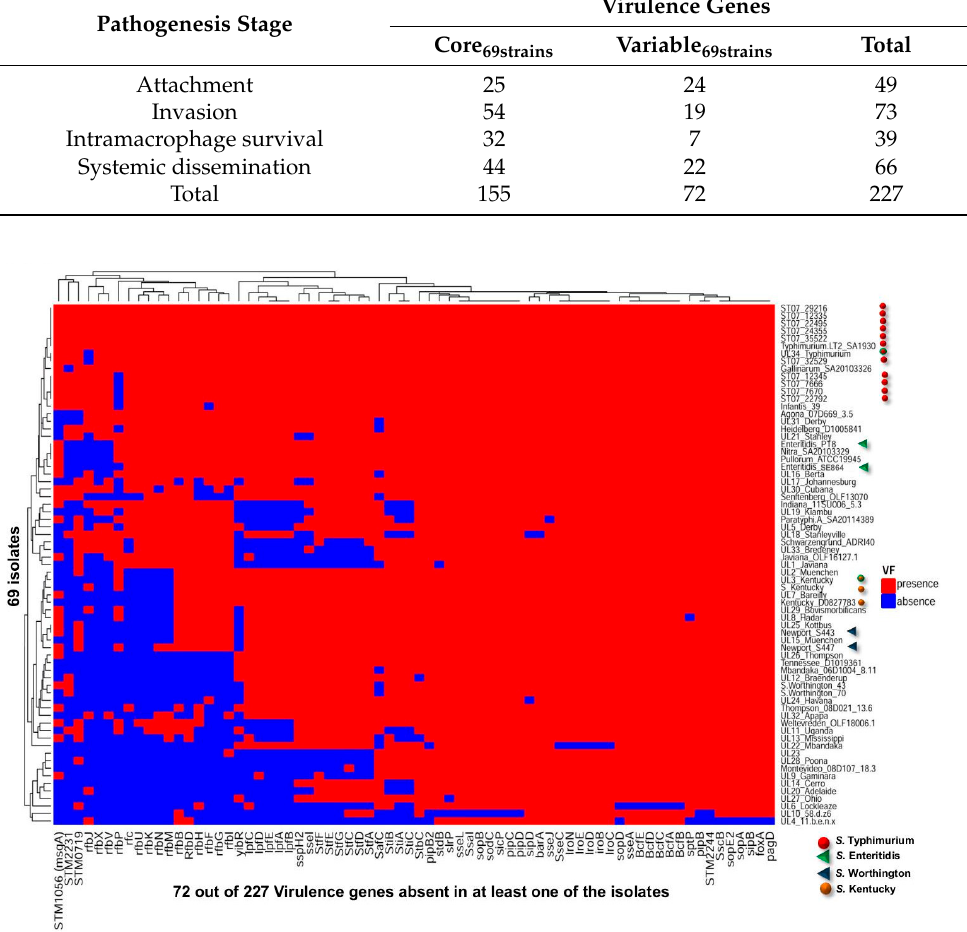
Figure 5. Heatmap illustration of reads presence/absence for 72 variable virulence genes (variable 69strains VGs) from a total of 69 Salmonella strains (35 OLF known and 34 SalFos strains). The x axis shows the 72 variable 69strains VGs while the y axis represents all the tested 69 Salmonella strains. Red and blue colors represent presence and absence of a VG, respectively. For annotation purpose: Typhimurium , Enteritidis ▲ , Worthington ▲ , Kentucky . The illustration is a pool of the data from Figure 4A,B to show the clustering of the Salmonella serovars based on analysis of VGs se ‐ quences. Table 5. Validation of AmpliSeq Salm_227VG based on blind assessment of virulence and serovar desig ‐ nation for 34 Salmonella strains.